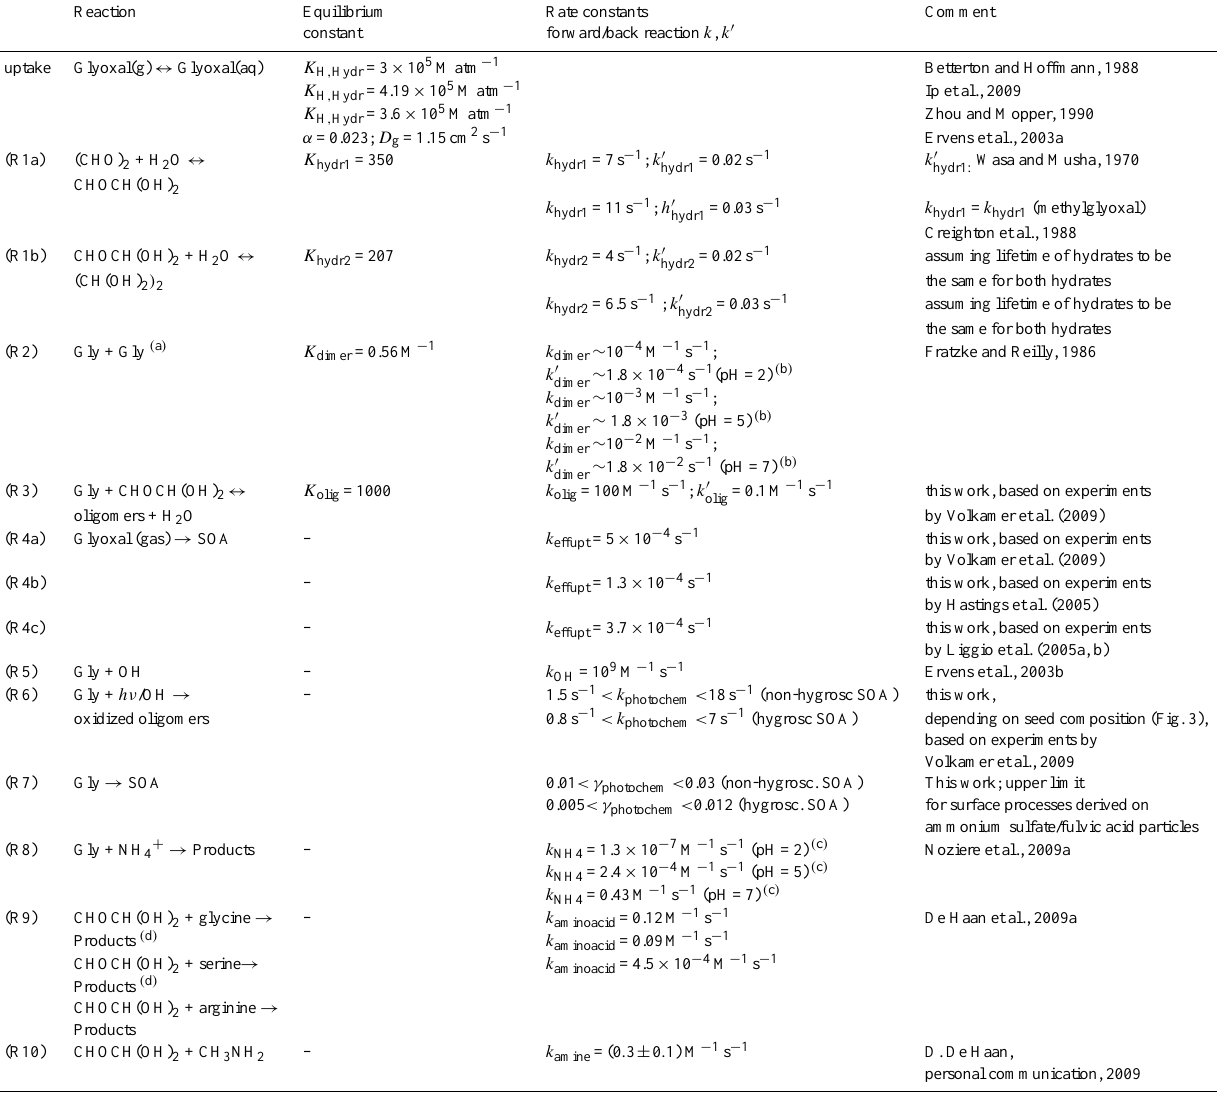
Table 2. Summary of reaction parameters of glyoxal reactions in the aqueous phase that are reported in the literature or have been derived in the present study based on laboratory studies. All rate constants k and equilibrium constants K are defined in the Appendix.